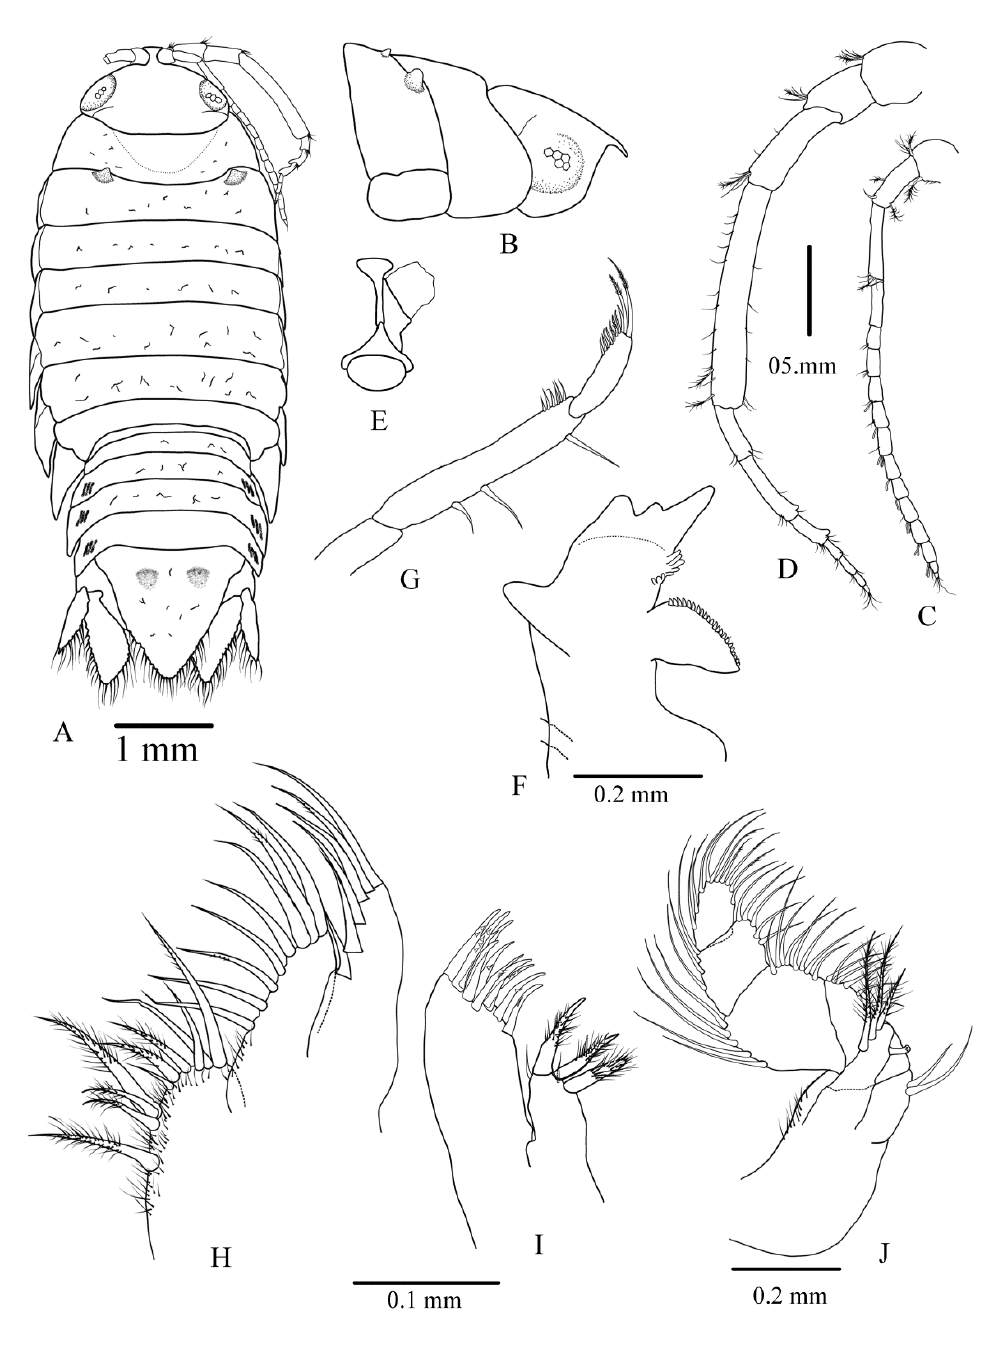
view; C, antennule; D, antenna; E, epistome; F, left mandible; G, palp of left mandible; H, maxillule; I, maxilla; J,